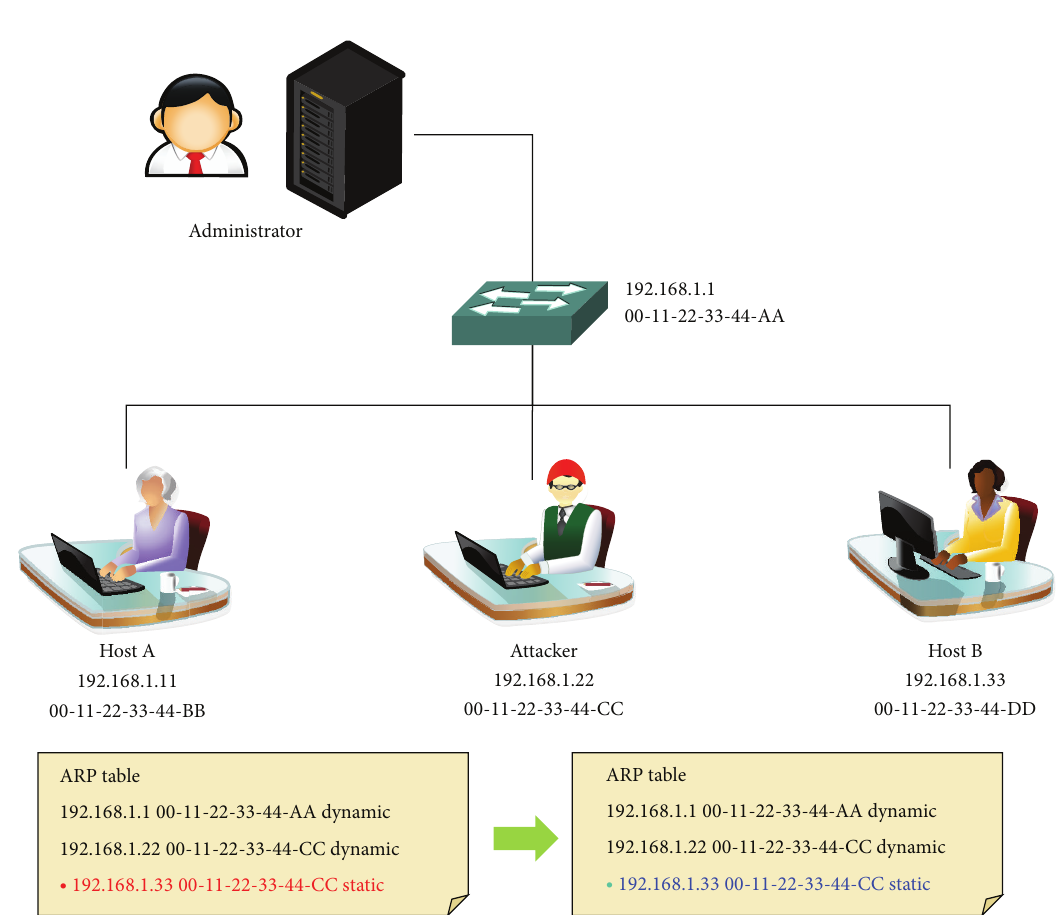
Figure 6: ARP spoofing